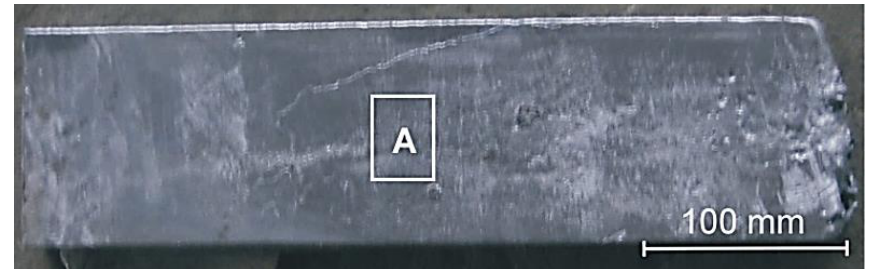
Figure 1. Plate casting with dimensions 400 mm × 120 mm × 40 mm cast in metal mold. A—test material taking area.